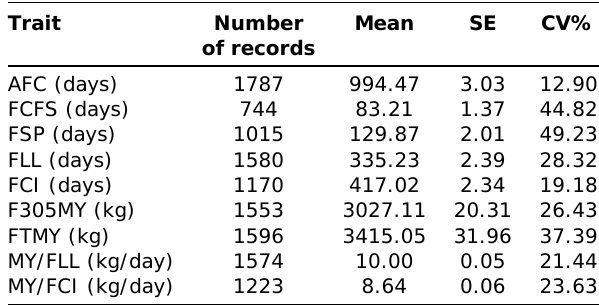
Table-1: Data structure and descriptive statistics of first lactation production and fertility